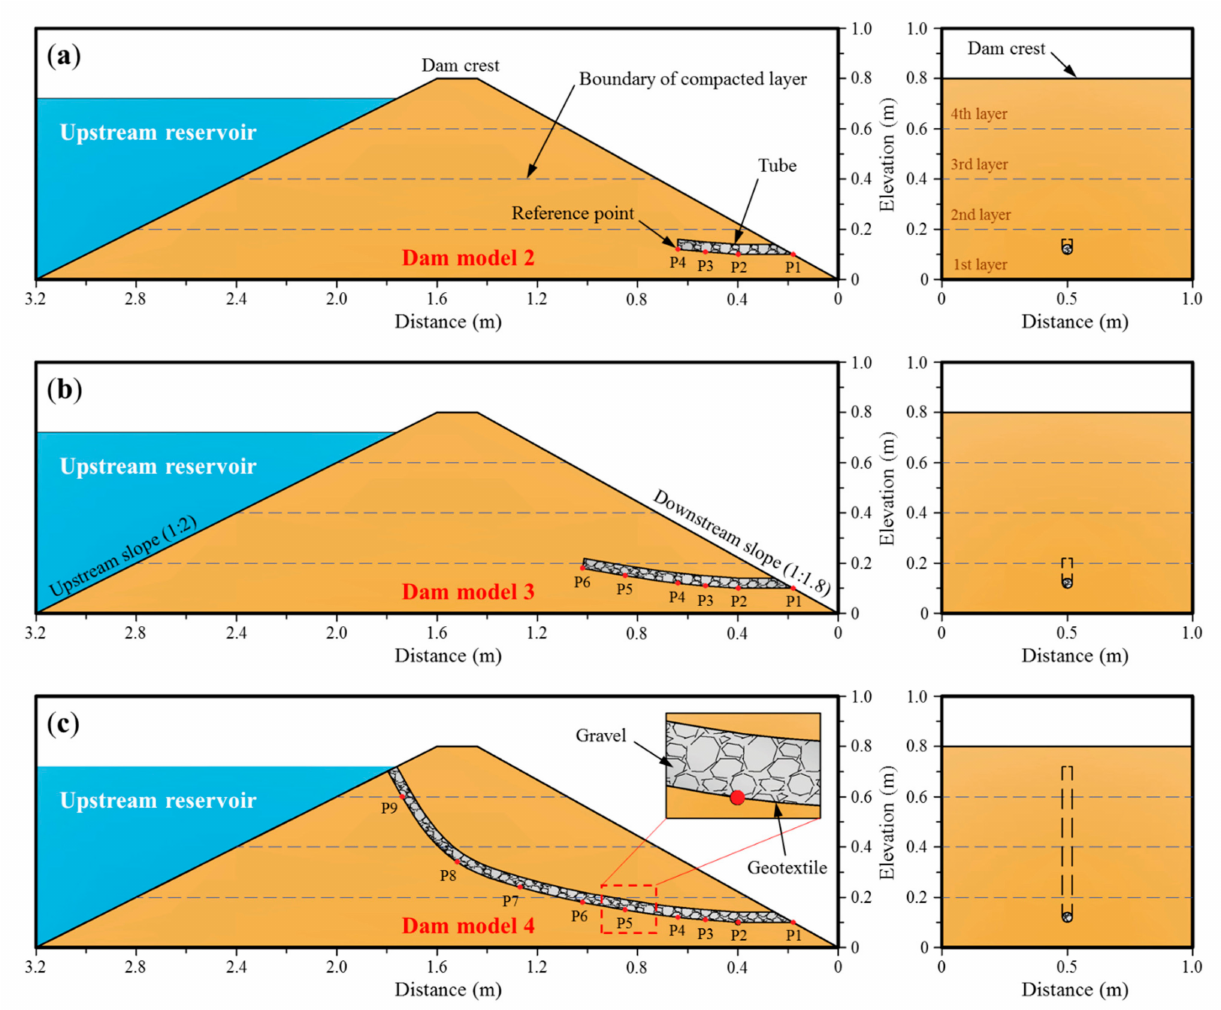
Figure 2. Cross-section and front view of dam models with geotextile tubes of different lengths. ( a ) DM 2 with a 50-cm-long geotextile tube. ( b ) DM 3 with a 90-cm-long geotextile tube. ( c ) DM 4 with a 180-cm-long geotextile tube. The description of the same details among the three subfigures is only added to one of them to avoid